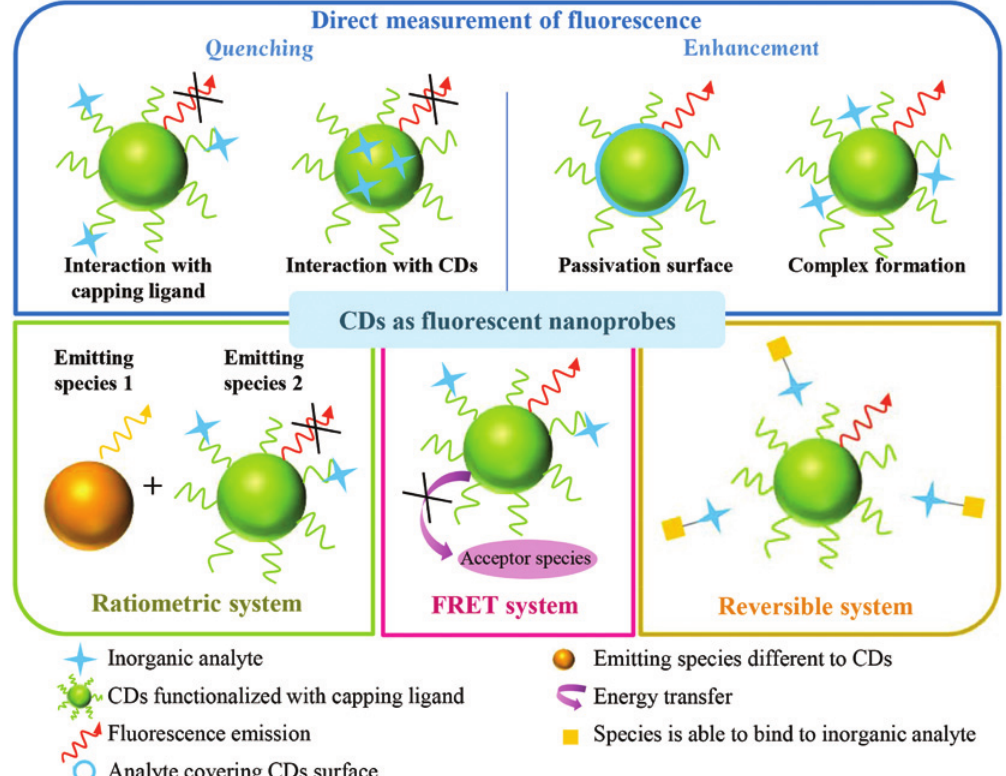
Figure 3: Processes involved in the sensing mechanisms using CD-based